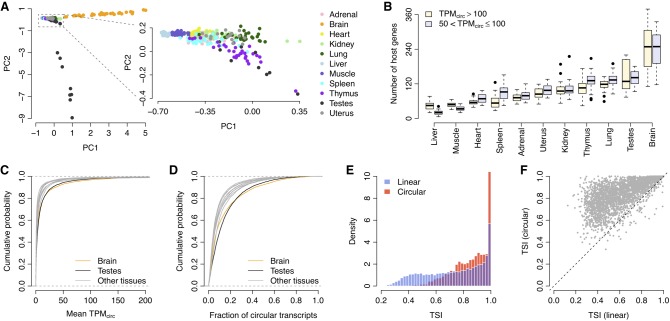
Tissue specificity of circRNA expression. (A) PCA of circRNA expression. Each dot represents one tissue sample. (PC1) First principal component, (PC2) second principal component. (B) Number of host genes with high circRNA expression. Genes with relatively higher TPMcirc were categorized into two groups: TPMcirc > 100 and 50 < TPMcirc < 100. Each boxplot consists of 32 samples from the specific tissue type, except for the testes and uterus, for which only 16 samples are included. (C) Cumulative distribution of the mean TPMcirc values across all 11 tissue types. (D) Cumulative distribution of the fraction of circular transcripts across all 11 tissue types. (E) Histogram of the TSI of both linear and circular transcripts. (F) Paired comparison of TSI between linear and circular transcripts. Each dot represents one host gene. The dots above the diagonal denote the host genes with a higher circRNA TSI than their linear counterparts.